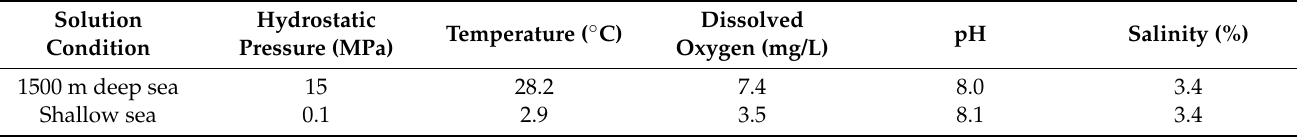
Table 1. Test conditions for simulating deep-sea and shallow-sea